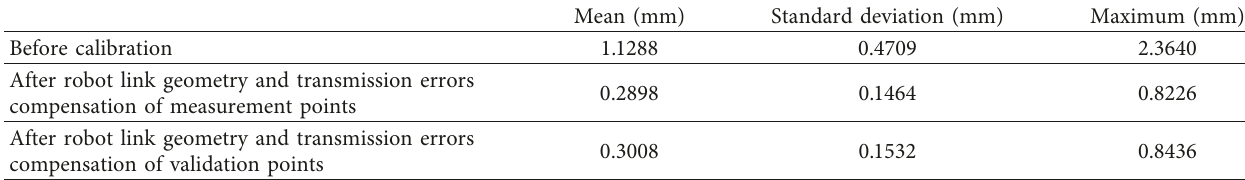
Table 5: Absolute positioning accuracy of the SIASUN SR210D robot.